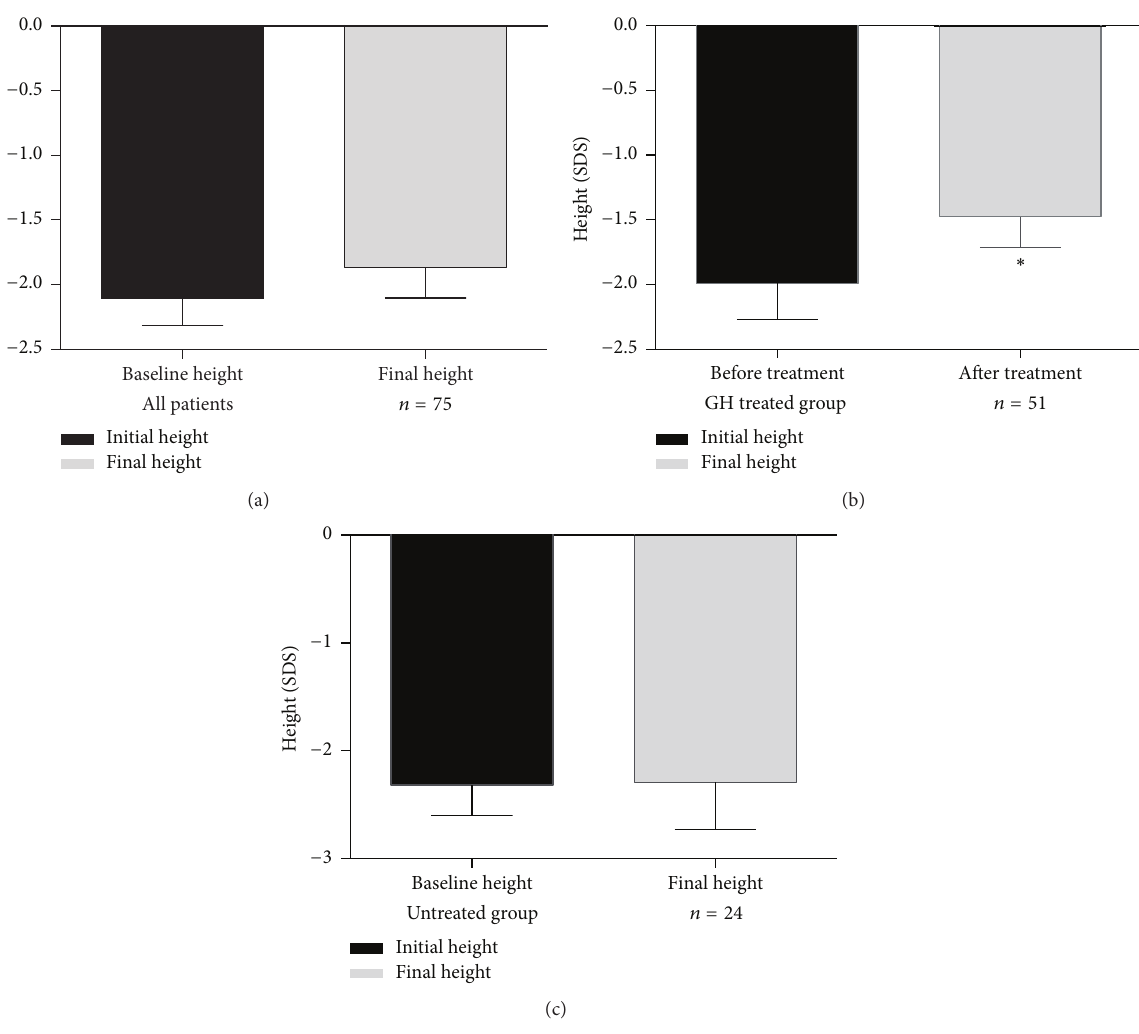
Figure 1: Final height changes after GH treatment. (a) Height changes for all the participants. (b) Height changes for GH treated cohort. (c) Height changes for untreated cohort ∗ 𝑃 < 0.05 .